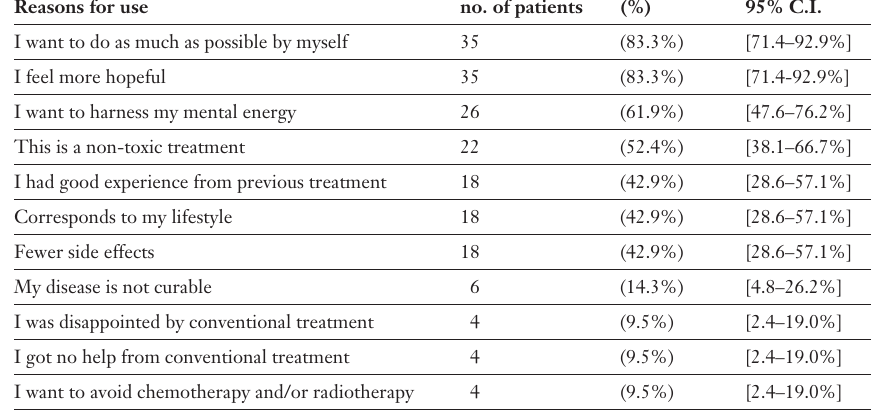
Reasons for the use of alternative thera- pies for cancer treat- ment (N = 42).